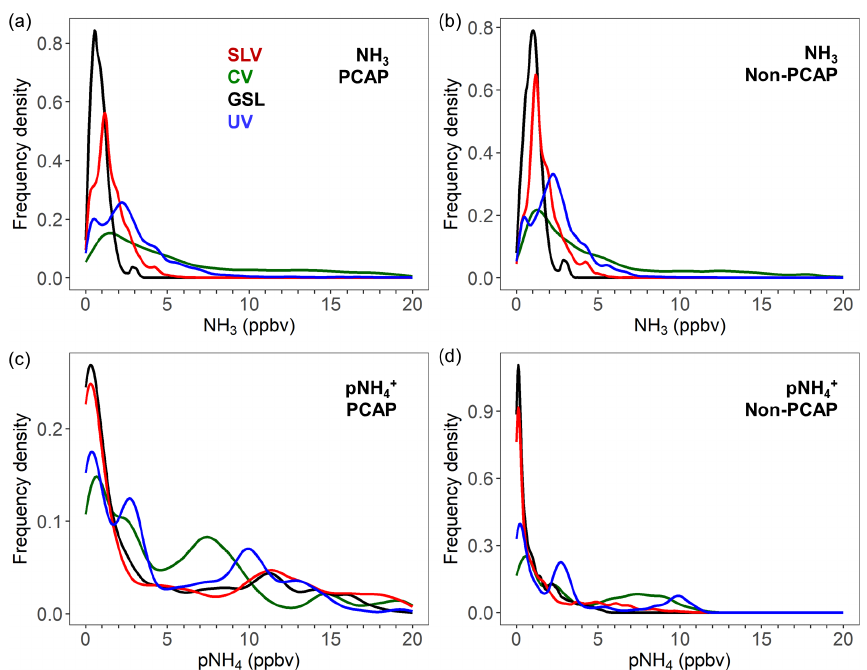
Figure 4. Frequency distribution of NH 3 (a, b) and p NH 4 (c, d) mixing ratios measured from the Twin Otter in Salt Lake Valley (SLV), Cache Valley (CV), Utah Valley (UV) and above the Great Salt Lake (GSL). The distributions are based on mixing ratios from all research flights, segregated into PCAP (a, c) and non-PCAP (b, d)